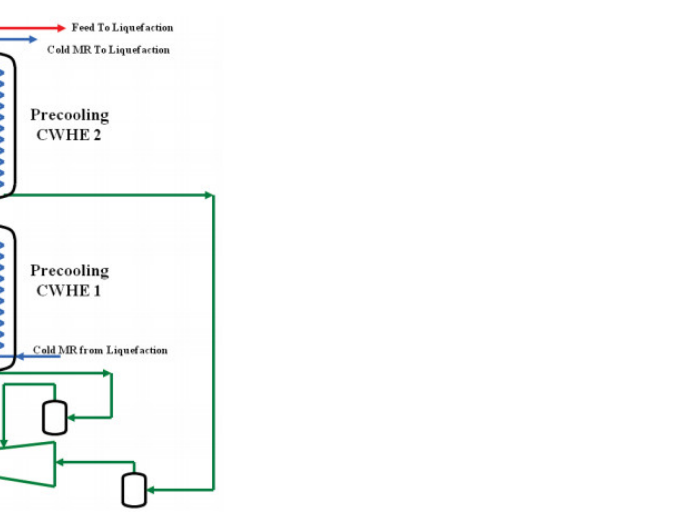
Figure 41. Single Pressure DMR Precooler, no Liquid Pump-around [161].